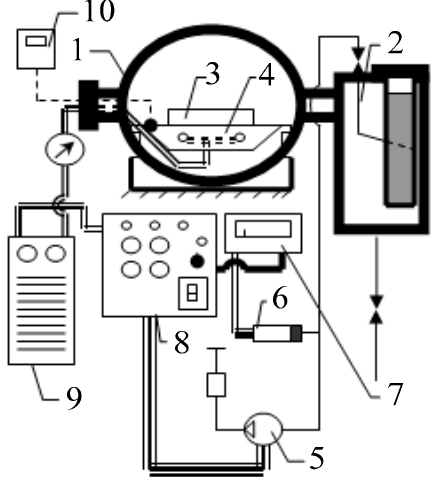
Figure 3. Vacuum sublimation apparatus: 1—sublimation chamber; 2—desublimator; 3—tray with a product; 4—heating stove; 5—vacuum pump; 6—gauge thermocouple; 7—vacuum gauge; 8—control panel; 9—universal voltage regulator, 10—electronic thermometer.